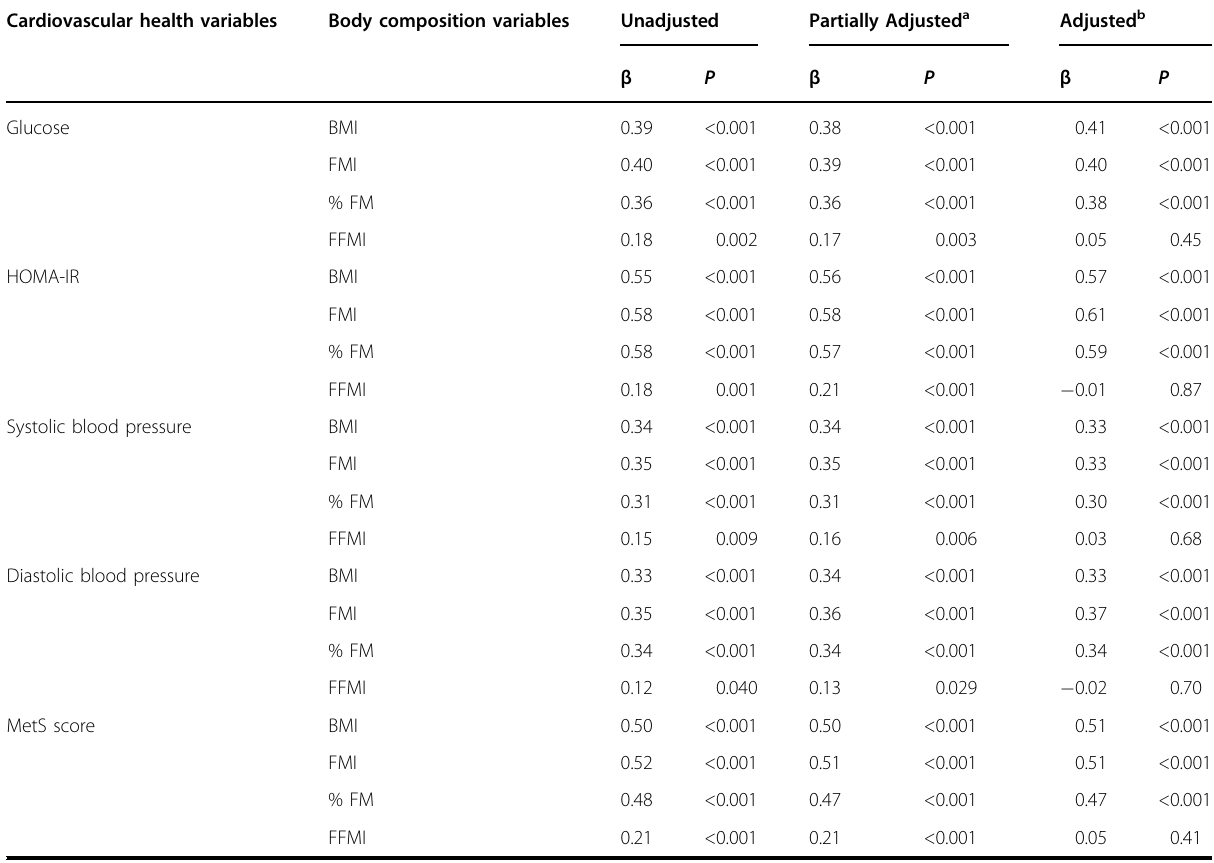
Table 2 Associations of body composition with cardiovascular health in early pregnancy examined by linear regression. Cardiovascular health